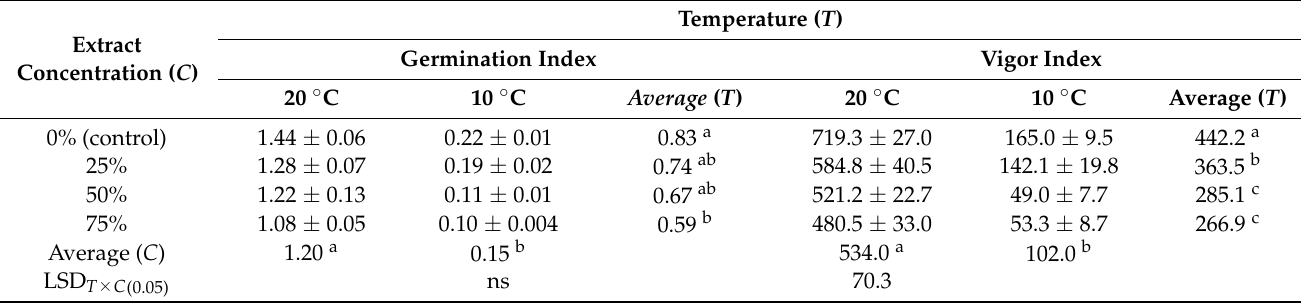
Table 9. Germination index (GI) and vigor index (VI) at two temperatures (20 and 10 ◦ C), in barley cv. Alamo in relation to the hemp leaf extract concentrations. For the main effects ( T = temperature, C = concentration), means followed by the same letter are not significantly different at p < 0.05 (Tukey’s test). LSD interaction value is also reported (ns = not